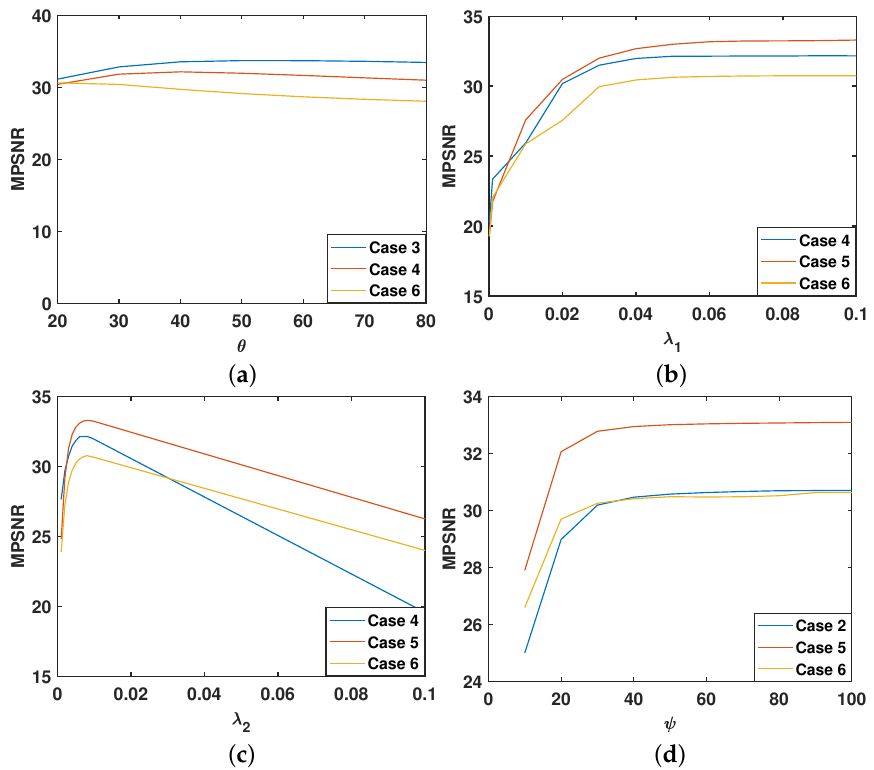
Figure 18. PSNR values concerning different values of ( a ) θ (controls ω ), ( b ) λ 1 , ( c ) λ 2 and ( d ) ψ (controls τ ).